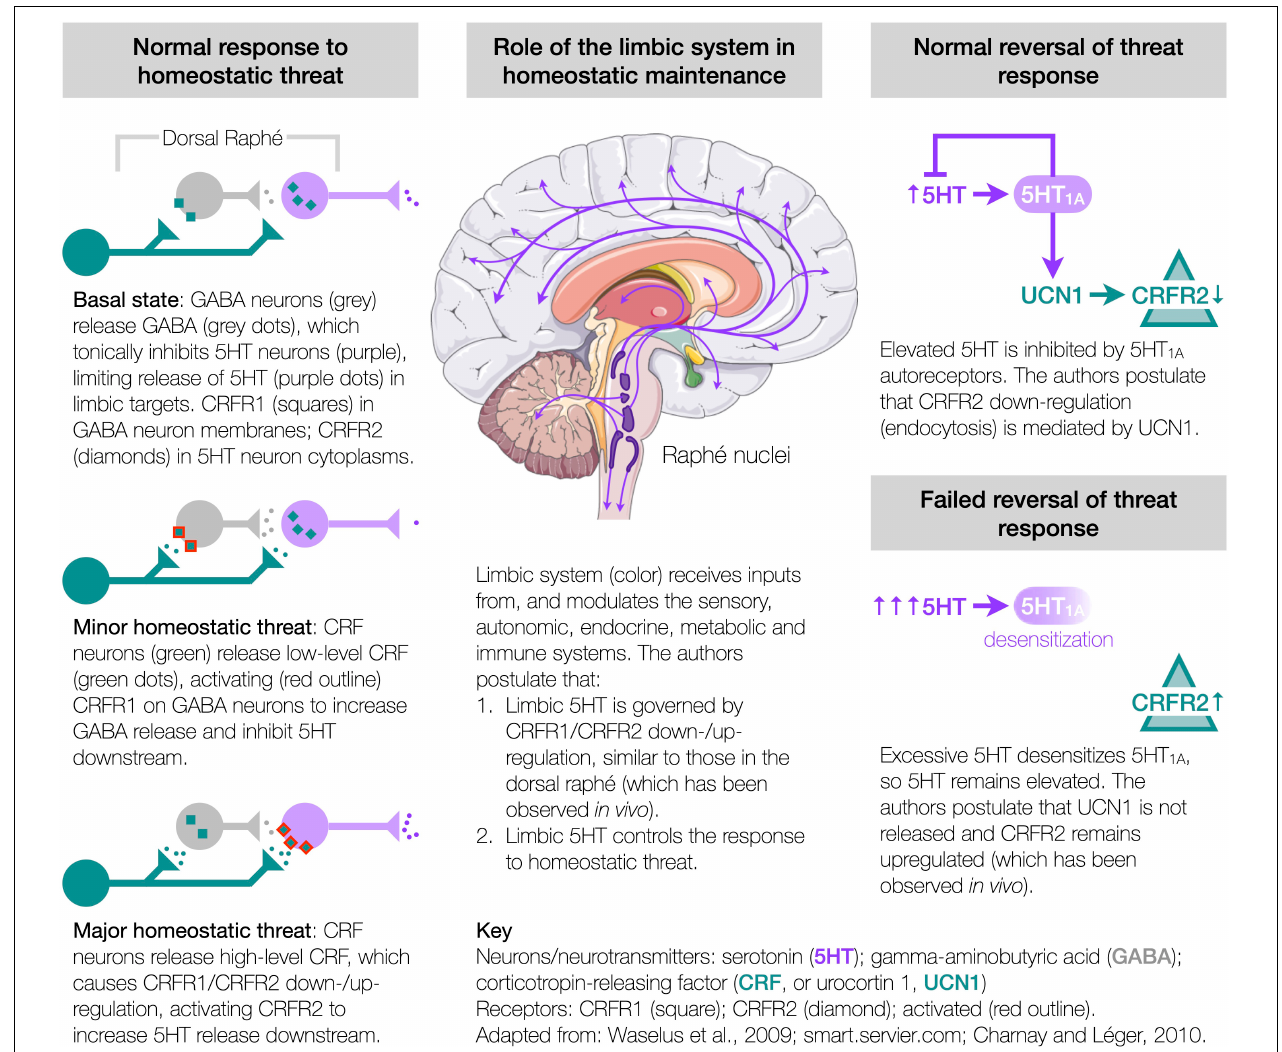
FIGURE 1 | Etiological